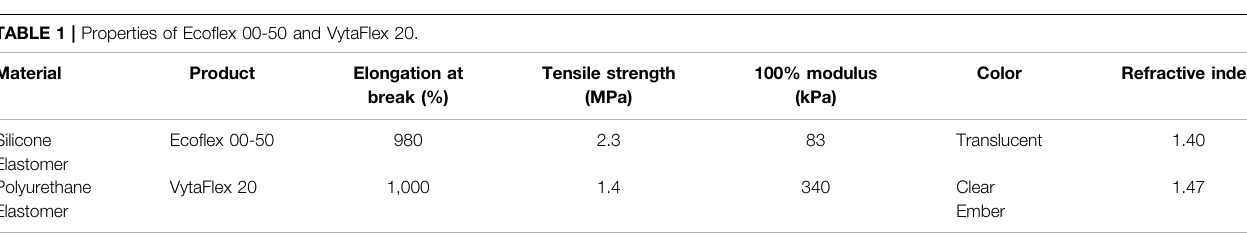
TABLE 1 | Properties of Eco fl ex 00-50 and VytaFlex